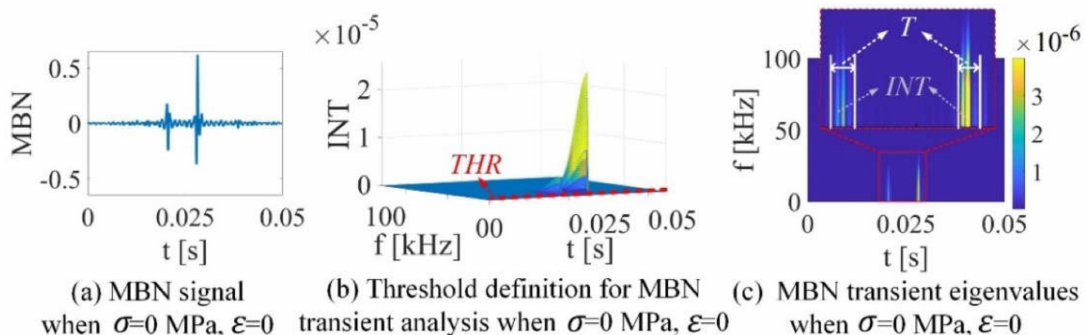
Figure 1. MBN transient analysis extracted from MBN signal: ( a ) the raw received MBN signal; ( b ) threshold definition for MBN transient analysis; ( c ) MBN transient eigenvalues (duration T and intensity INT